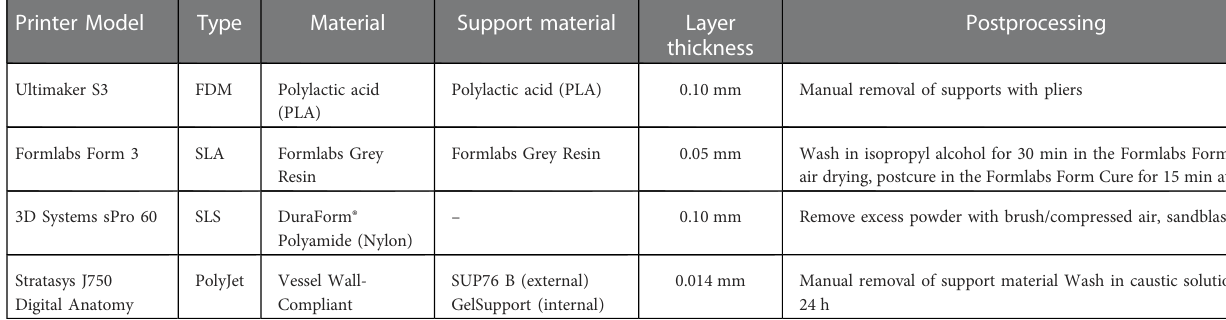
TABLE 1 3d printing modalities and